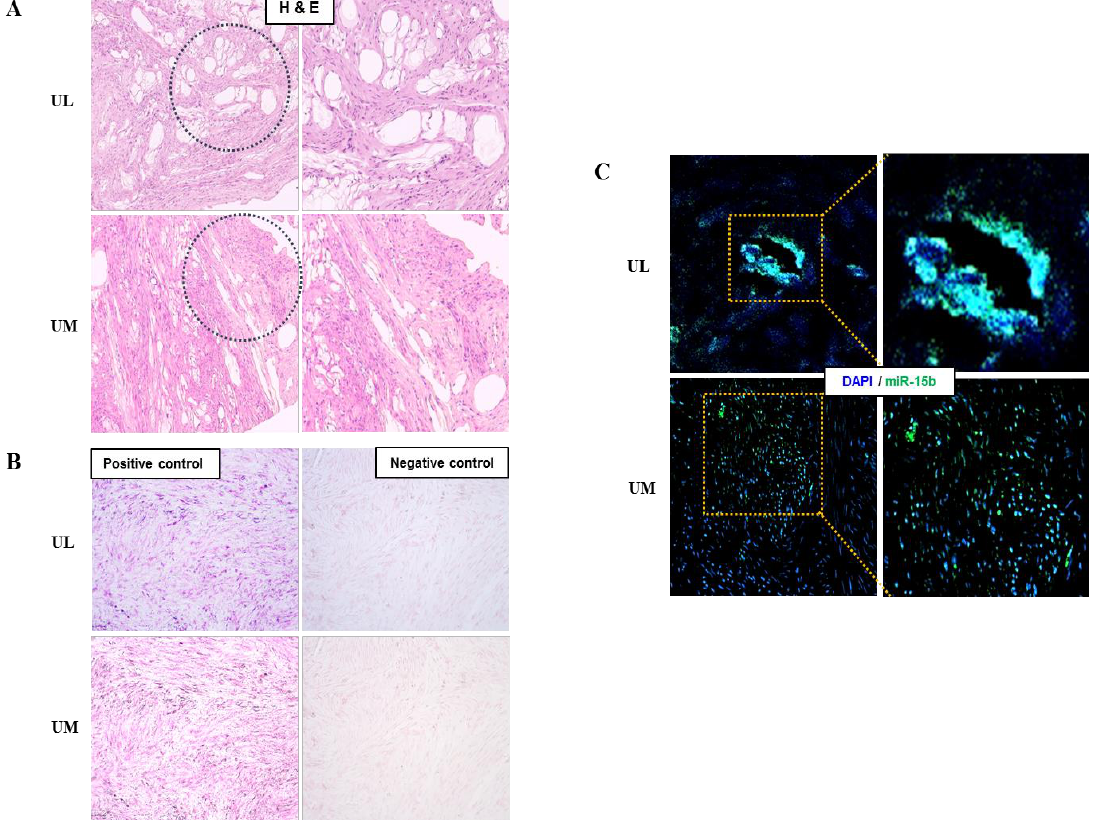
Figure 2. Detection of miRNA expression in human uterine leiomyoma tissue using in situ hybridization. ( A ) Observation of leiomyoma tissue (H&E staining, ×100). ( B ) Leiomyoma positive and negative control (Fast red staining, ×200). ( C ) Evaluation of miR-15b expression in leiomyoma tissue using miR-15b in situ hybridization (green, ×200).